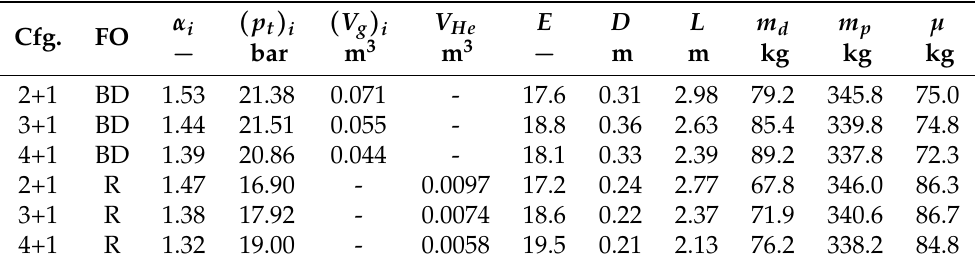
Table 8. Hybrid engine design and performance: sample return mission. The first column (Cfg.) reports the launcher configuration, e.g., 2+1 stands for two engines in the first stage and one engine in the second stage. The second column reports the feed system, blow down (BD) or regulated (R). V He is the volume of pressurizing gas D and L are engine diameter and length. m d is the engine dry mass and m p is the propellant mass.